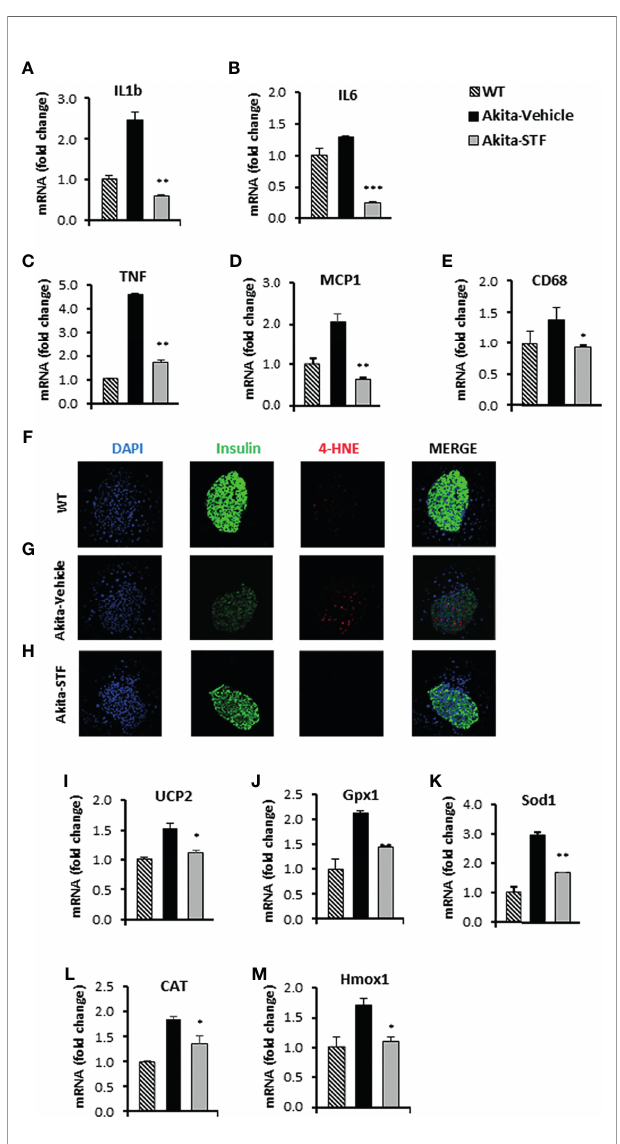
FIGURE 6 | STF attenuates the ER stress-associated in fl ammation and oxidative stress. (A – E) mRNA levels for indicated genes involving in fl ammation were analyzed in islets isolated from Akita mice treated with STF or vehicle (as in) by qRT-PCR. The results are expressed as the fold-increase over mRNA levels and are representative of 3 independent experiments. (F – H) Immuno fl uorescent staining in pancreatic sections. Pancreatic sections were stained with anti-insulin antibody (green, b -cell marker), 4-HNE (red, oxidative stress), and DAPI (blue). Slides were imaged with an Olympus FV1000 confocal microscope. (I – M) mRNA levels for indicated anti-oxidant genes were analyzed in islets isolated from Akita mice treated with STF or vehicle by qRT-PCR. The results are expressed as fold change and are representative of 3 independent experiments. *P < 0.05, **P < 0.01, and ***P < 0.001 compared to Akita-vehicle group. Bars indicate